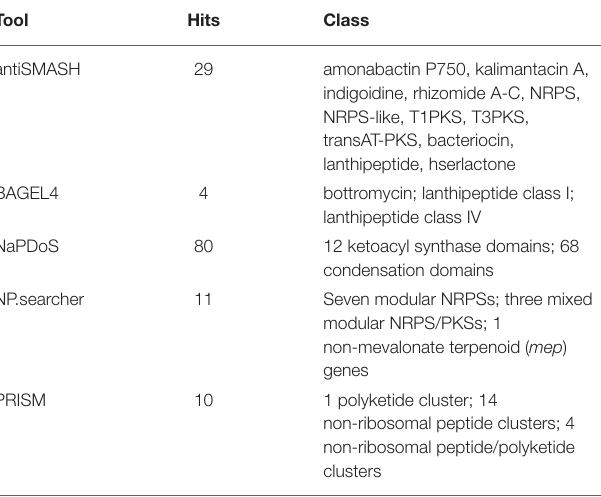
TABLE 7 | Secondary metabolite gene clusters via various bioinformatic tools.